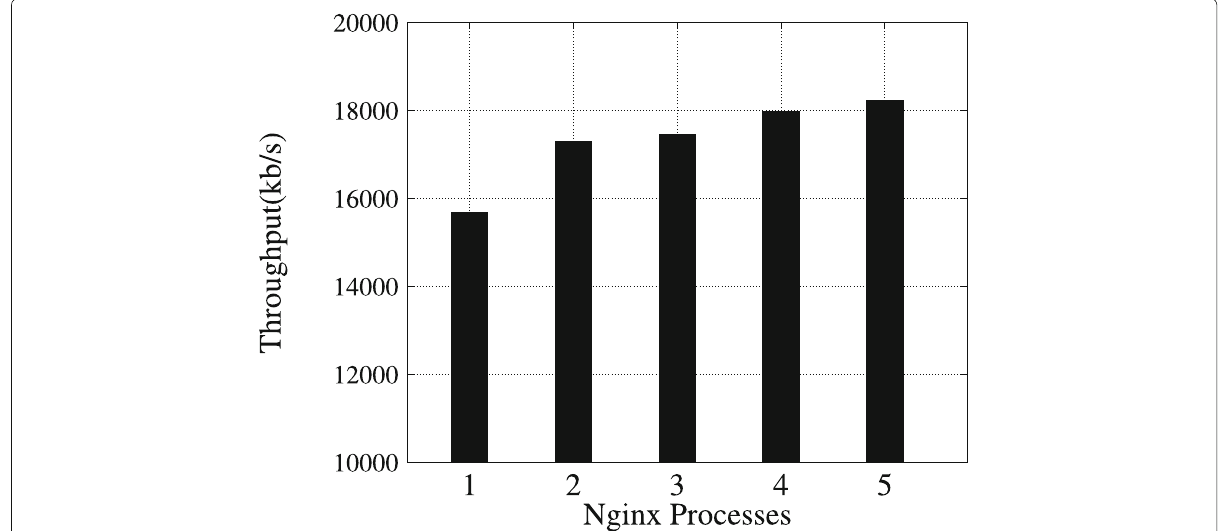
Fig. 7 The throughput (in kbytes/second) of Nginx server with different numbers of